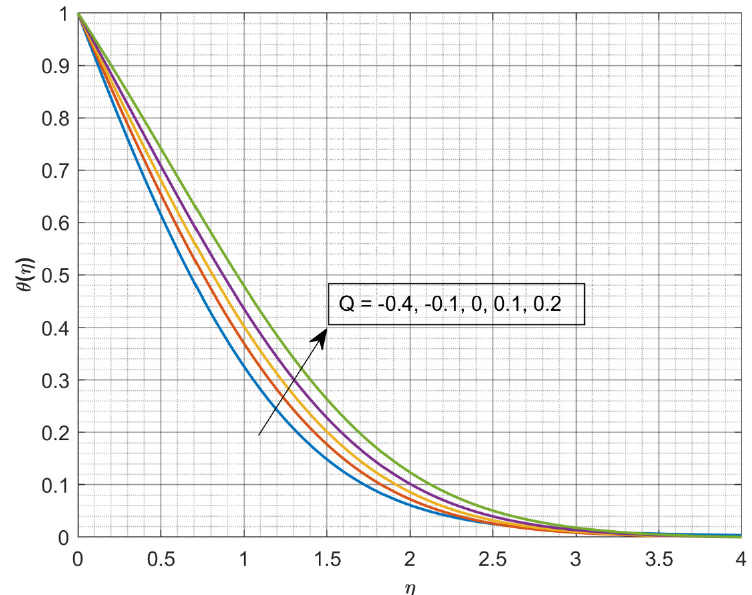
Figure 5. Influence of 𝑄 on 𝜃(𝜂) .